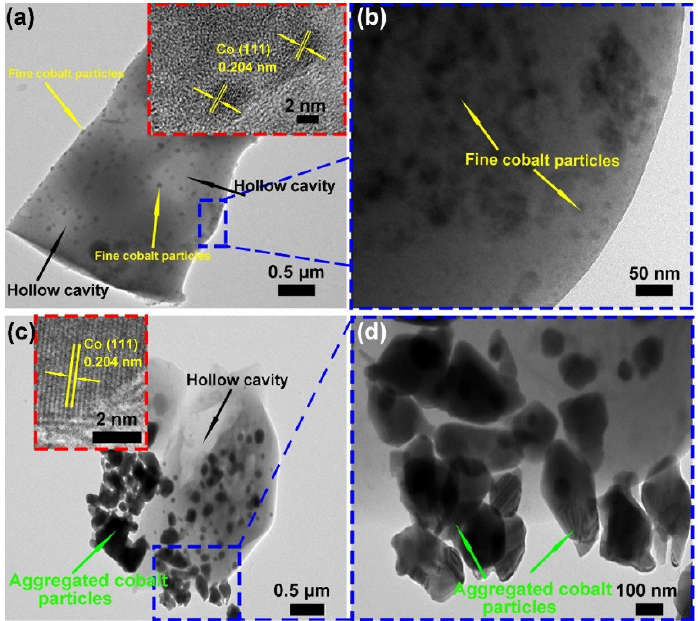
Figure 2. HR-TEM images of ( a , b ) HC–Co–YC–0.075M and ( c , d ) HC–Co–YC–0.05M.